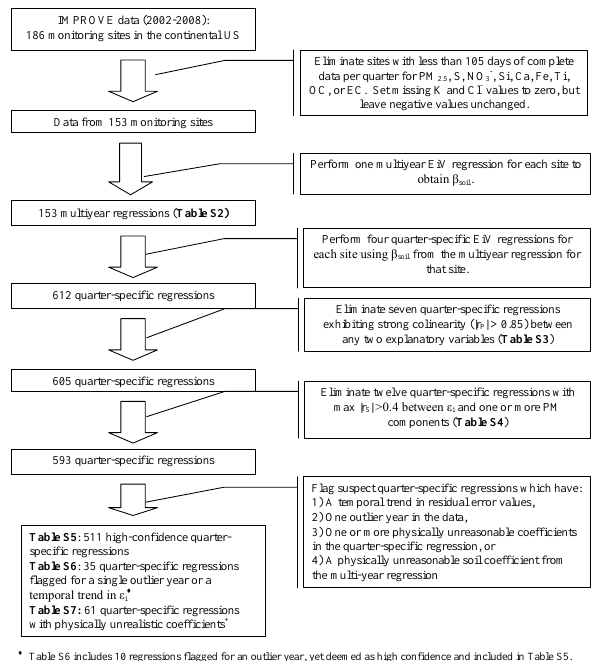
Fig. 1. Flow diagram outlining regression methodology used in this work. Some results appear in multiple tables as indicated by the